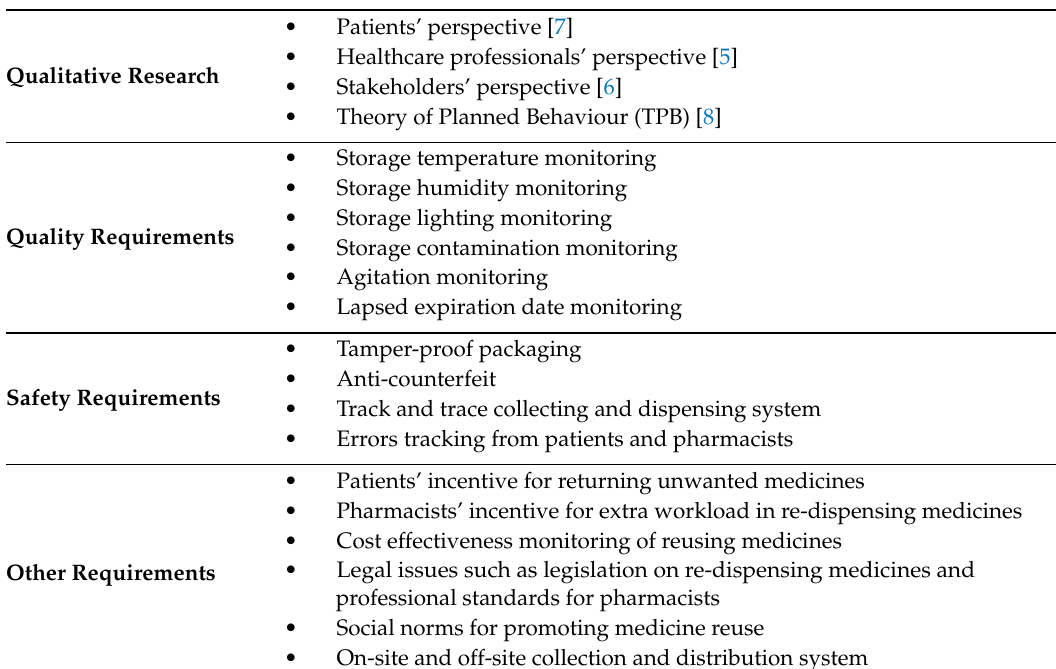
Table 1. Major requirements for medicine reuse through qualitative research (data extracted from Hui et al.